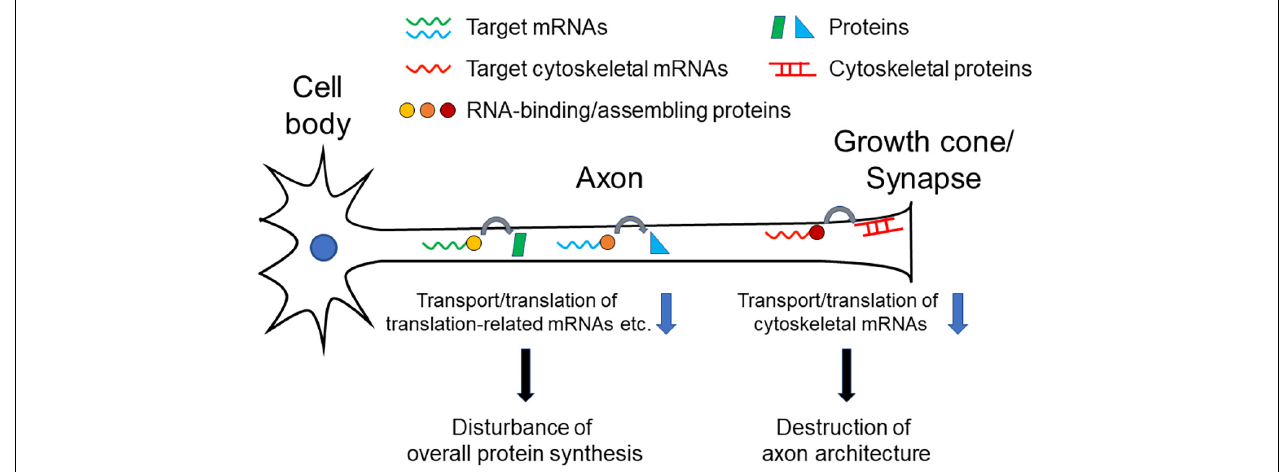
FIGURE 1 | Pathogenetic model of neurodegenerative diseases. Decrease in transport/translation of cytoskeleton-related mRNAs results in inhibiting maintenance of structural integrity of axons, especially of growth cone or synapses, leading neuronal dysfunction and degeneration. Decrease of transport/translation of translation-related (e.g., ribosomal protein mRNAs) mRNAs or many target mRNAs causes dysregulation of overall protein synthesis in axons, which leads neuronal dysfunction and degeneration.